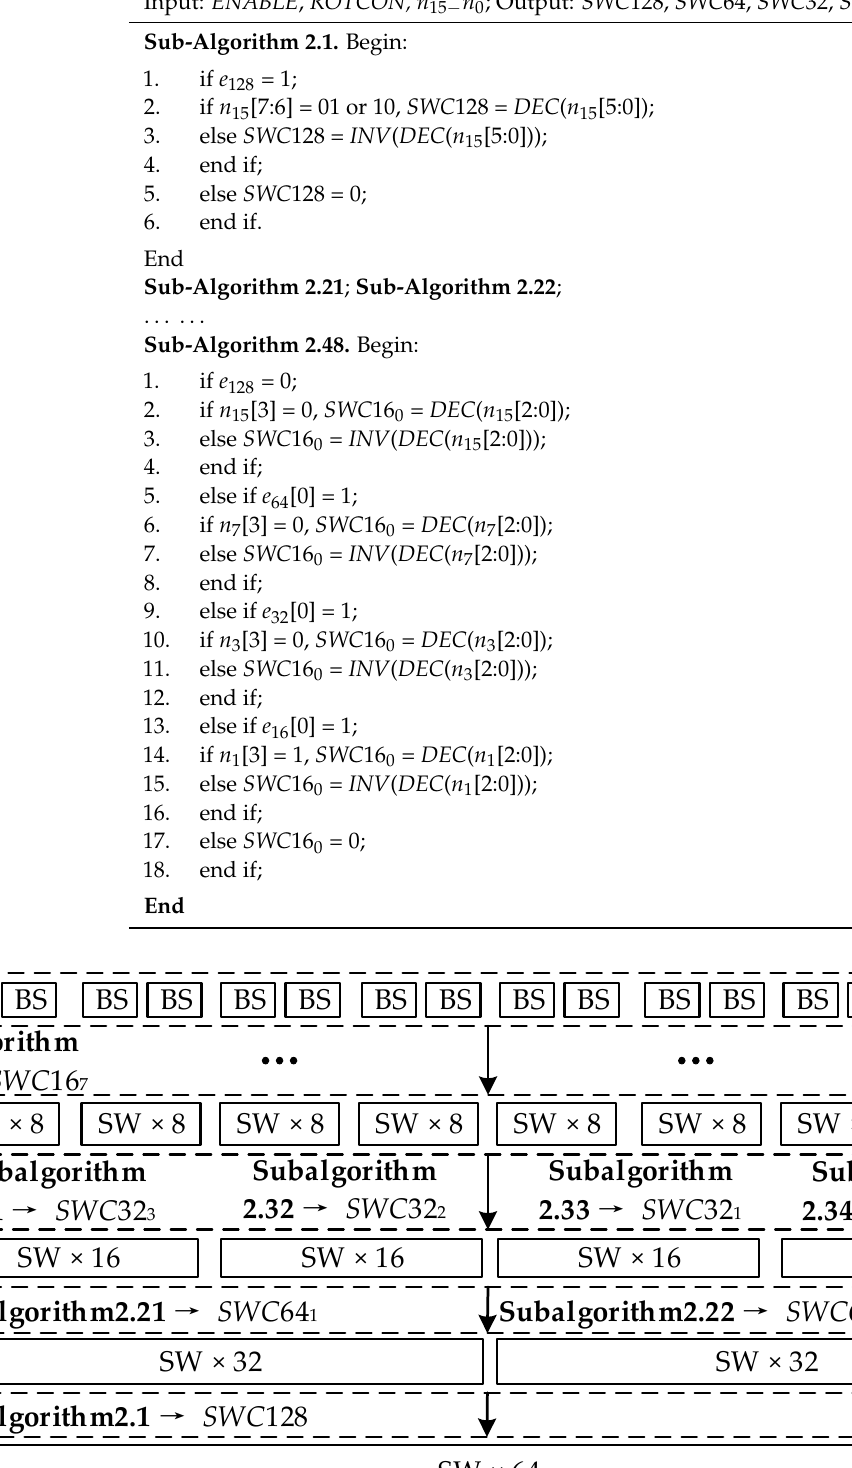
Algorithm 2: The algorithms for generating SWC